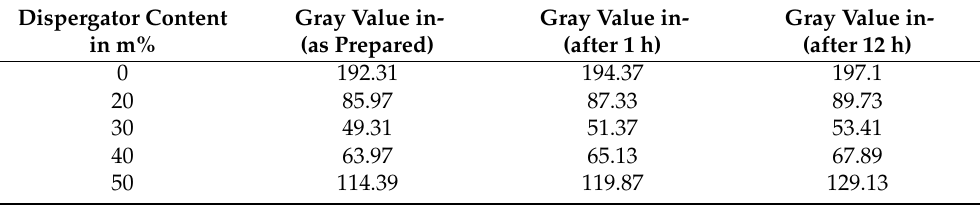
Table A15. Gray values of CB dispersions as a function of PVP content at different times. Dispergator Content Gray Value in- Gray Value in- in m%